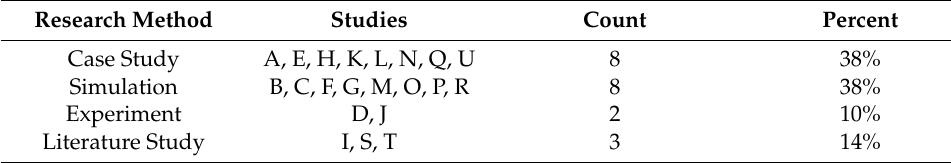
Table 2. Overview of the research methods of the selected studies.